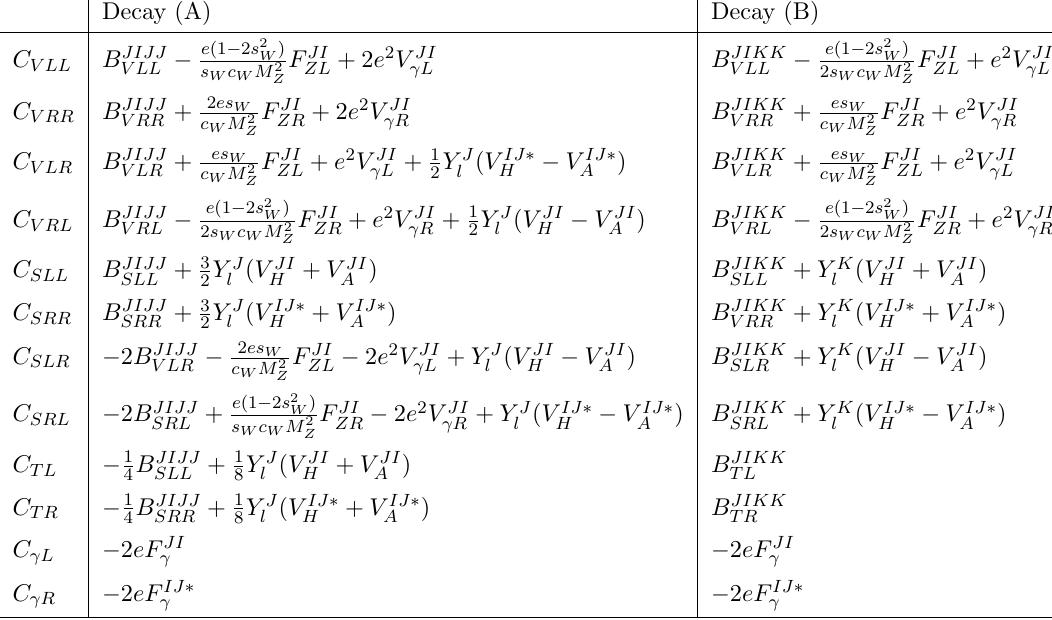
Table 1 . Coe(cid:14)cients C N ; C (cid:13) of eq. (3.7) and eq. (3.9) for decay types (A) and (B). B QXY , B TX denote the irreducible box diagram contributions (see eq. (2.21)), the terms with F Z stem from the Z penguin Lagrangian (eq. (2.7)), V (cid:13) is the sum of the vector-like photon contributions (eq. (2.5)), Higgs contributions are de(cid:12)ned in eq. (3.10) and the coe(cid:14)cients F (cid:13) of the magnetic operator are de(cid:12)ned in eq.